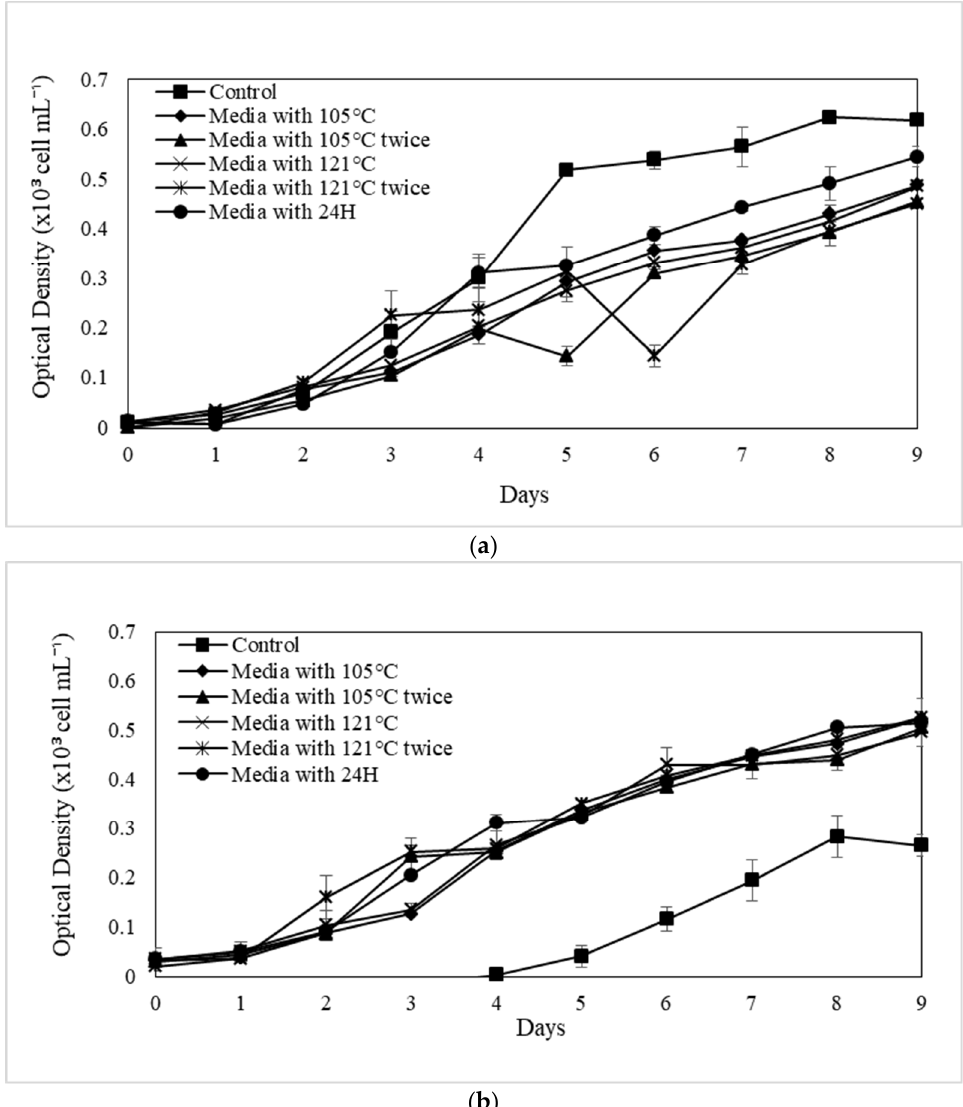
Figure 4. OD at 680 nm of N. conjuncta in control (media without soil extract), media with 105 °C, media with 105 °C twice, media with 121 °C, media with 121 °C twice, and media with 24 h (media with 105 °C—autoclave 105 °C; media with 105 °C twice—autoclave 105 °C 2 × after natural extraction 24 h; media with 121 °C—autoclave 121 °C after natural extraction 24 h; media with 121 °C × 2—autoclave 121 °C twice after natural extraction 24 h; media with 24 h—natural extraction for 24 h). ( a ) RMFR SE and ( b ) AHFR SE. The error bars ( n = 3) indicating the standard deviation.